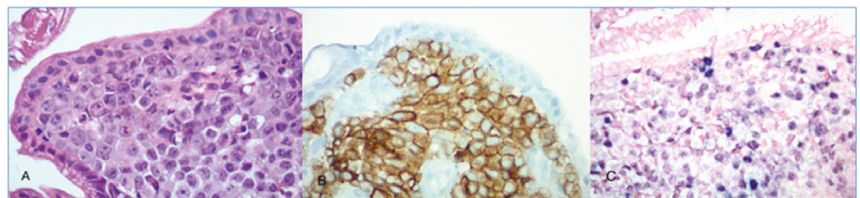
Figure 3: Histological evaluation of gastric mucosa. Slide (a): High-grade lymphoma seen under the gastric surface epithelium. Slide (b): Positive reactivity for CD30 with the use immunostaining. Slide (c): Tumor cells found to be positive for Epstein–Barr virus-encoded small RNA (EBER) with in situ hybridization. Image Credit: Kunchang